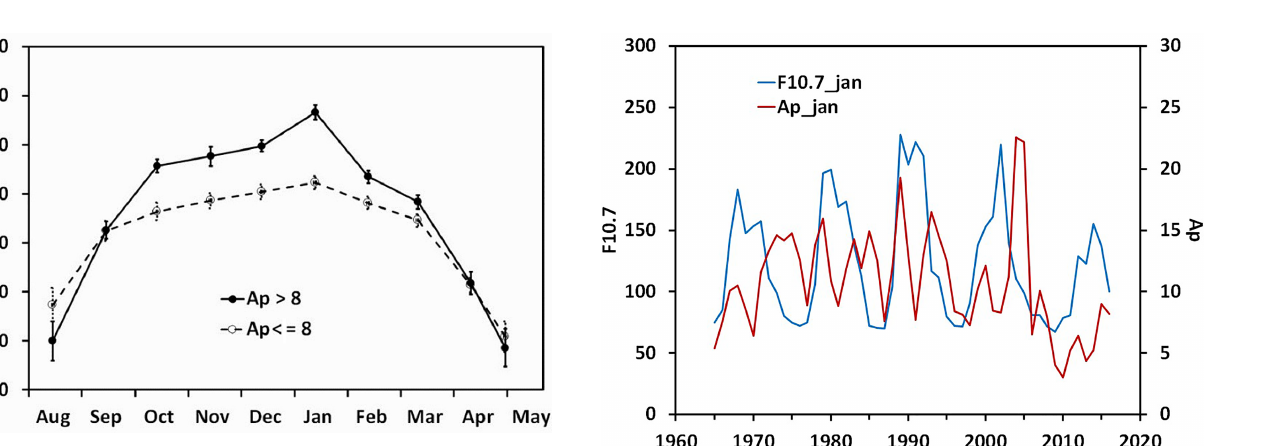
Figure 5. The F10.7 and Ap index averages for January from 1975 to